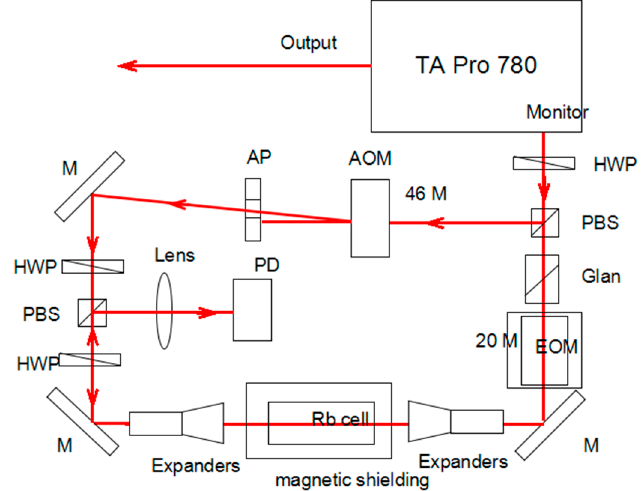
Figure 4. Scheme of reference laser frequency stabilization. (M: mirror. HWP: half wave-plate; PBS: polarizing beam splitter cube; EOM: electro-optic modulator; AOM: acousto-optical modulator; Expander: beam expander; AP: aperture).